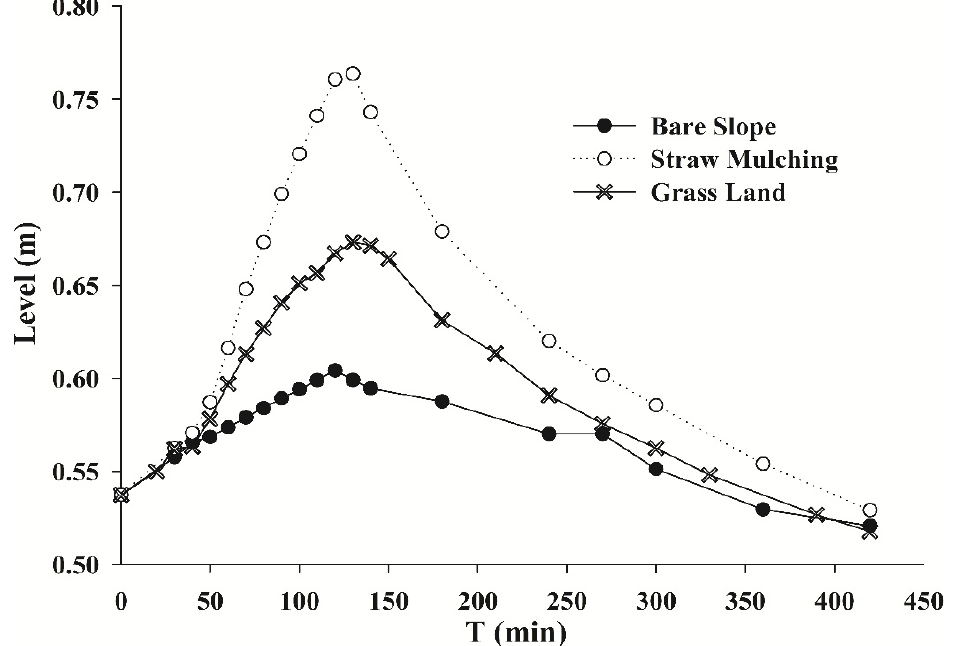
Figure 16. Time-series graphs of the groundwater level fluctuations among three scenarios during the simulated